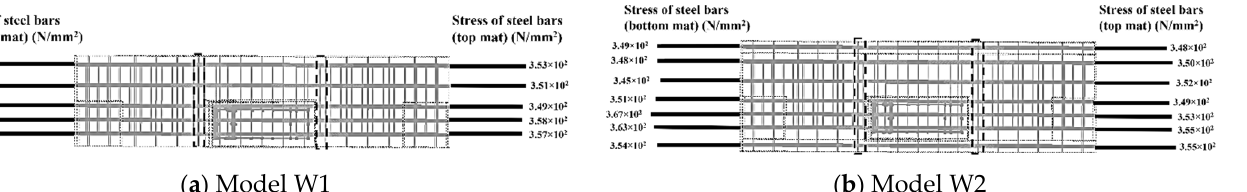
Figure 23. Lateral strength versus drift ratio curves for slab width models.